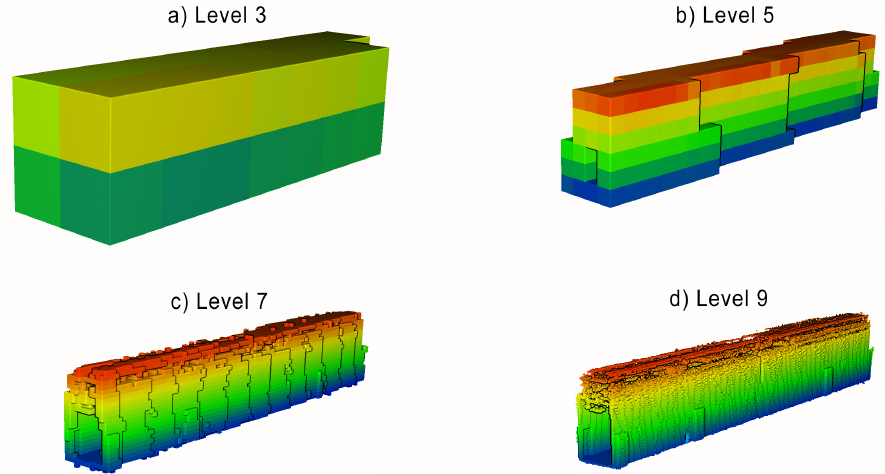
Figure 7. Example volumetric visualizations of an octree at levels: 3, 5, 7 and